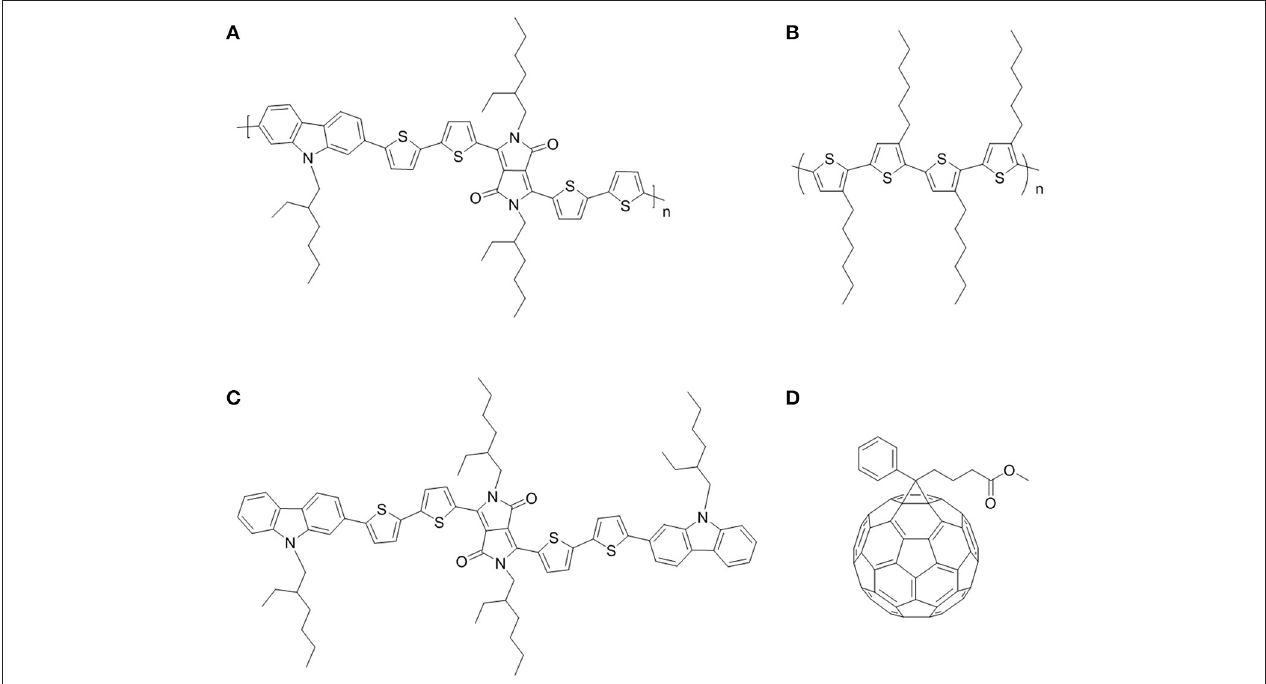
FIGURE 1 | Chemical structures of photovoltaic materials: PCDPP4T (A) , P3HT (B) , DPP4T-Cz (C) , and PCBM (D)